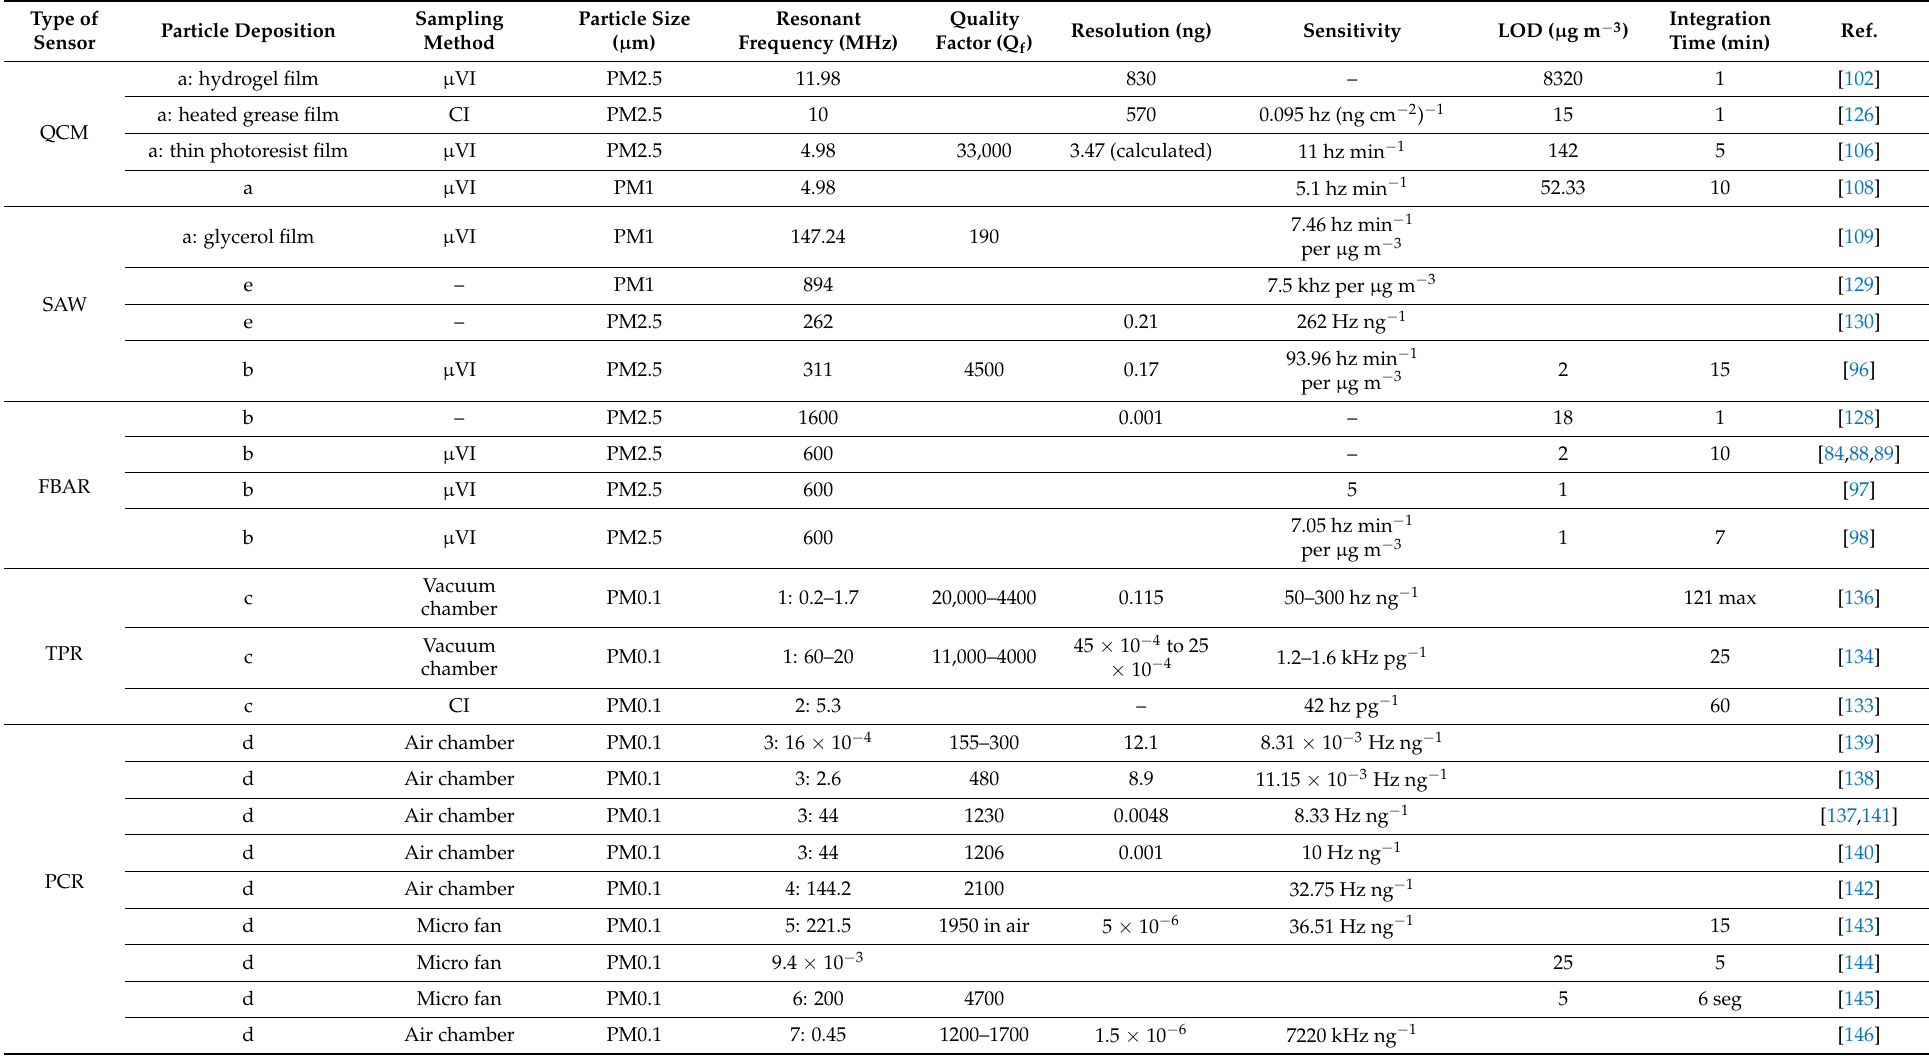
Table A2. Comparison between the key design and performance parameters of the MEMS and NEMS sensors for airborne PM detection found in the literature. Type of